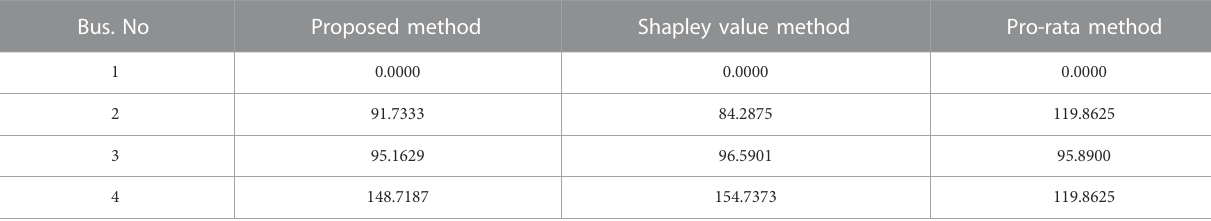
TABLE 2 Comparison of allocated losses (in kW) of 4-bus DS by all three given methods. Bus. No